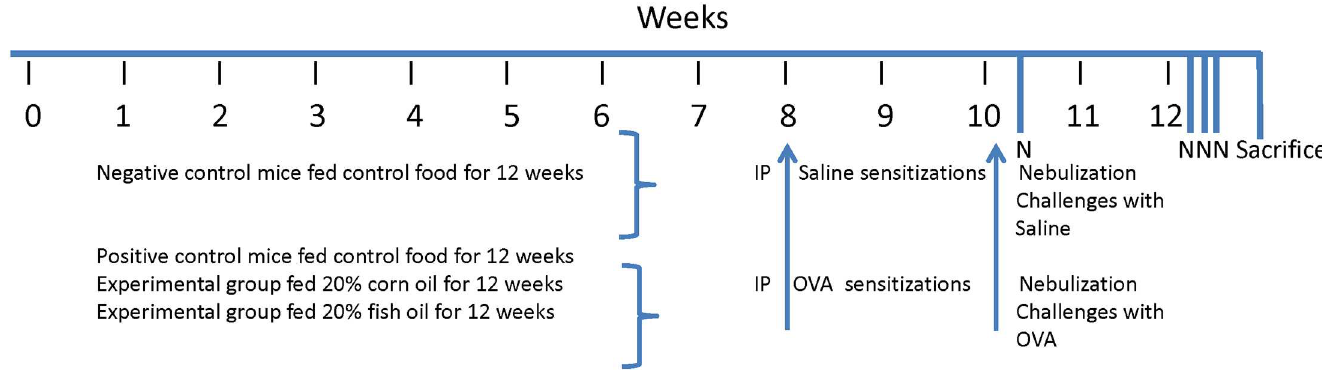
Fig 1. Time line for the experimental protocol. Mice continuedto eat their respective foods throughoutthe allergensensitization and challenge period. They were sensitized with saline or OVA at 8 and 10 weeks, and then challengedby nebulization with saline or OVA once at 10 weeks and on three consecutive days during week 12. Mice were sacrificed 24 h after the final